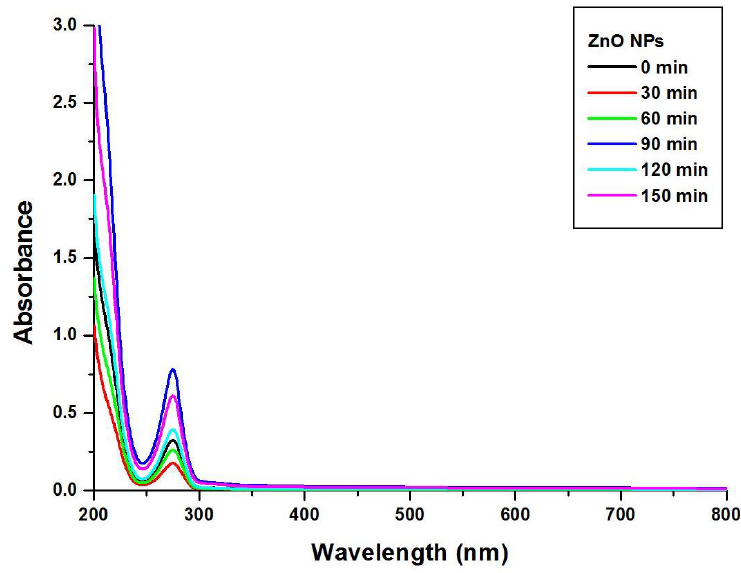
Figure 1. UV–visible spectroscopy of ZnO Figure 1. UV – visible spectroscopy of ZnO NPs